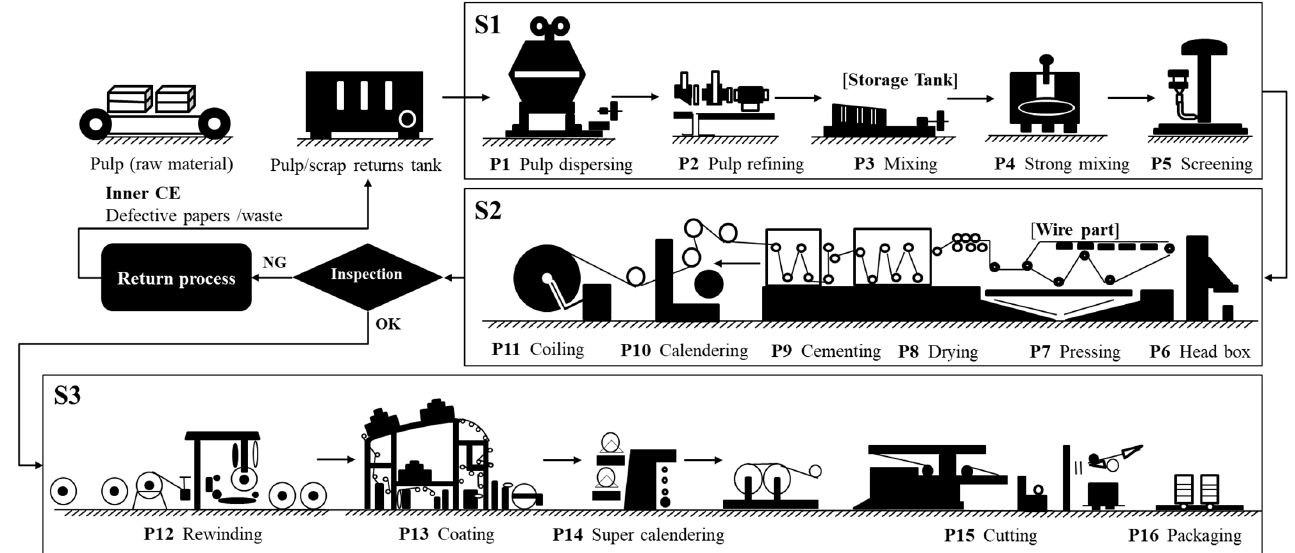
Figure 4. Production system for the manufacturing process of paper with inner CE.